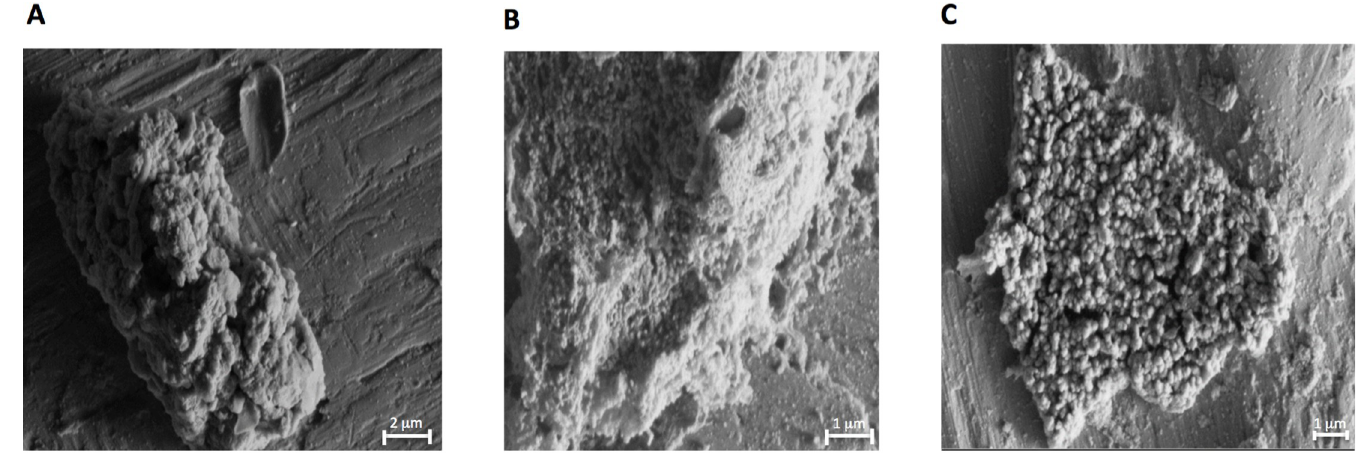
Fig 3. SEM analysis of representative MSSA biofilms. Biofilms were allowed to form onto titanium coupons for 72 hours and subsequently treated with 0.1% CAGE for a) 0, b) 5, and c) 120 minutes.